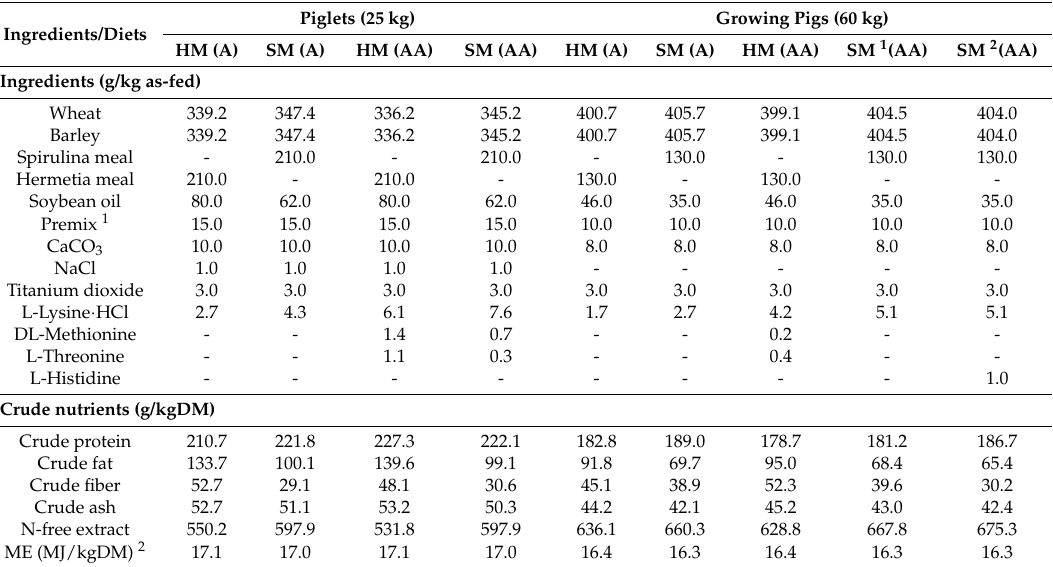
Crude nutrients (g/kgDM) Crude